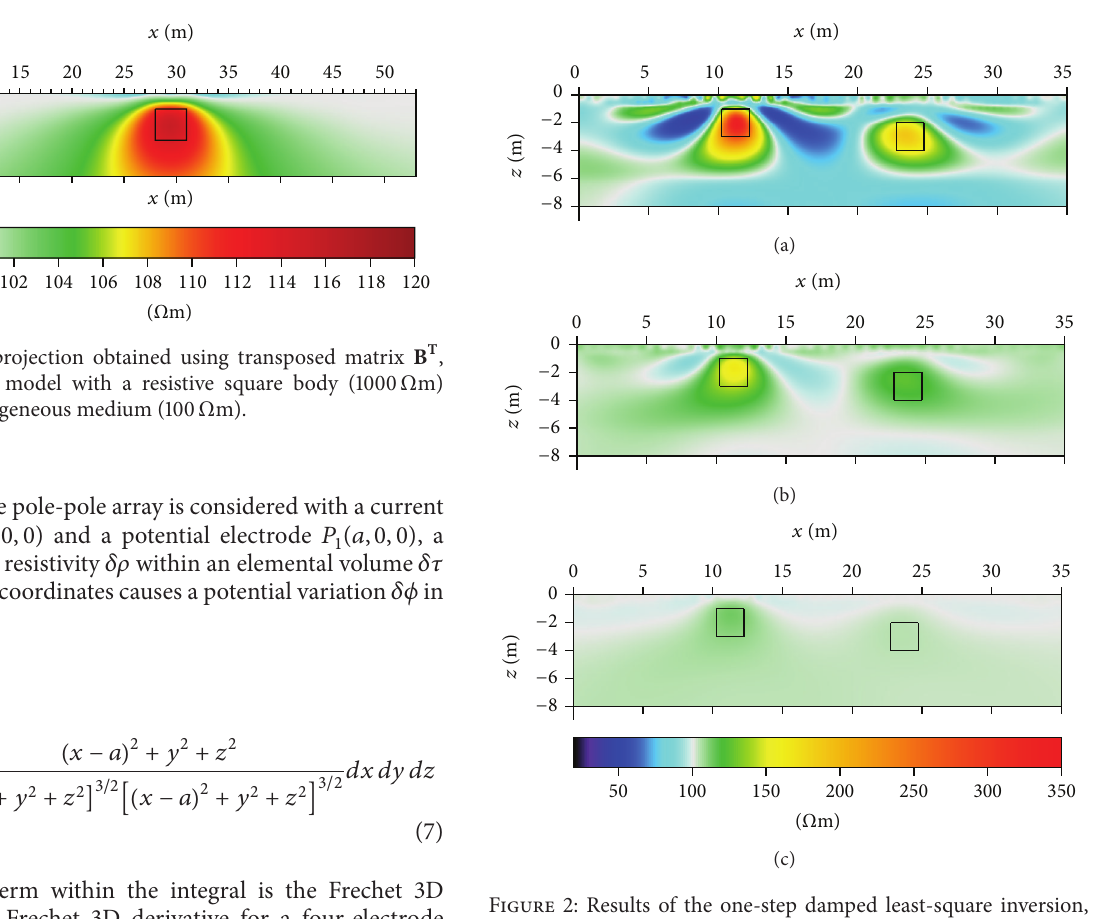
Figure 2: Results of the one-step damped least-square inversion, obtained by using different damping factors 𝜆 , on a 2D model with two equal square bodies (1000 Ω m) buried in a homogeneous medium (100 Ω m) at different depths. (a) 𝜆 = 0.003, (b) 𝜆 = 0.03, and (c) 𝜆 =